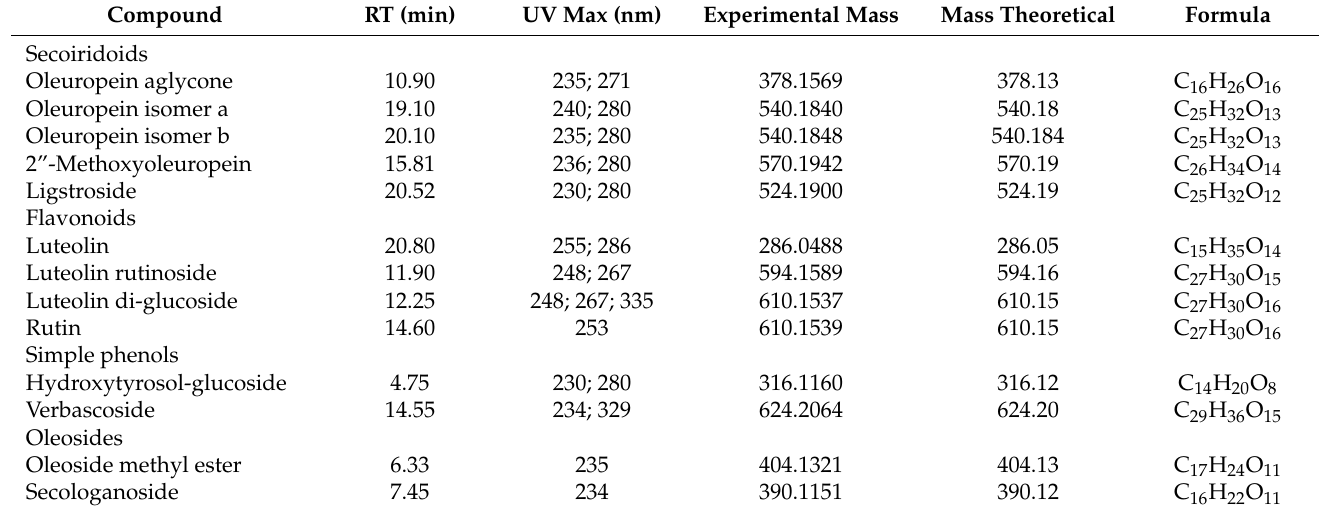
Table 2. Phenolics’ identification